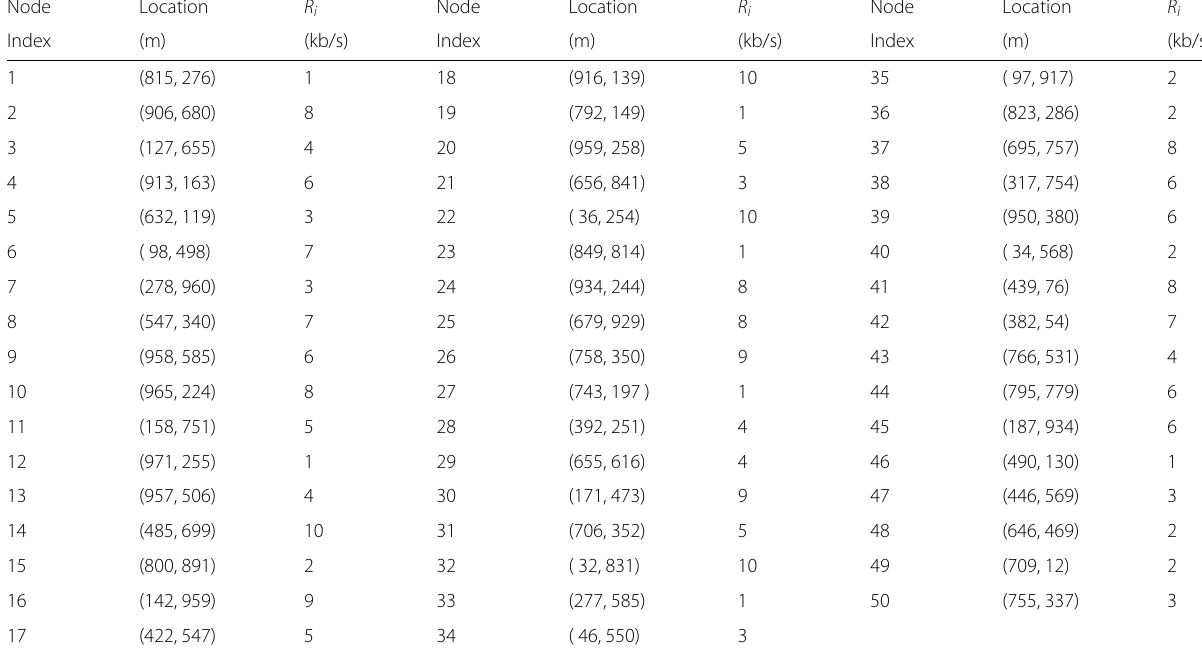
Table 2 Location and data rate for each node in a 50-node network Node